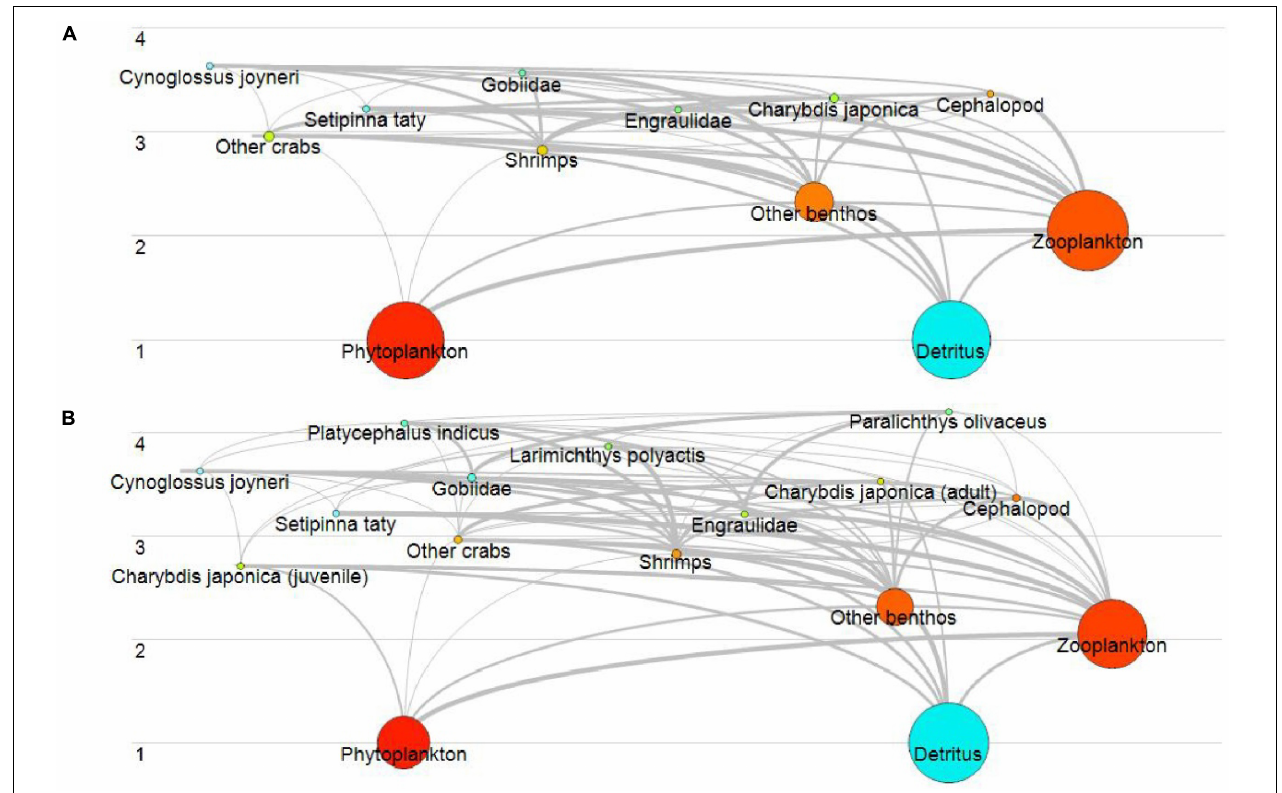
FIGURE 2 | Food web of artificial reef of Juehua Island in summer (A) and autumn (B) of 2019.